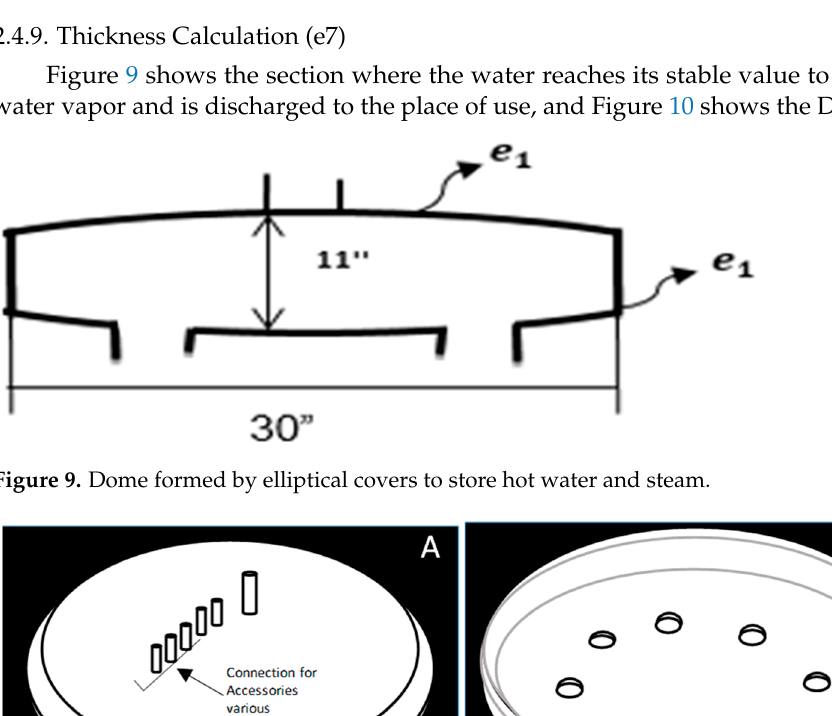
Figure 9. Dome formed by elliptical covers to store hot water and steam.